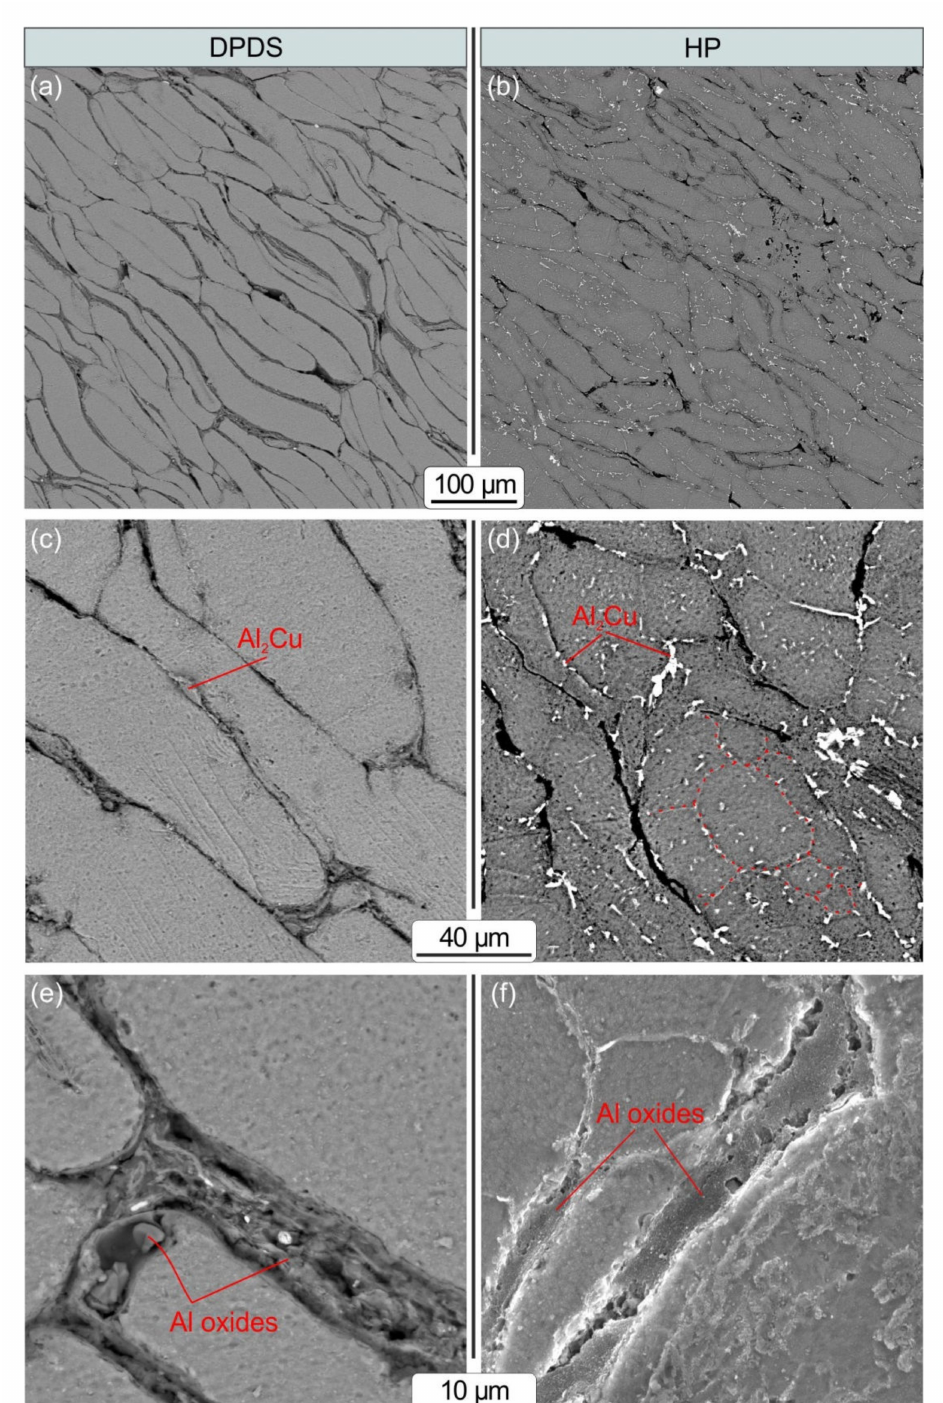
Figure 5. Microstructure of the nanocomposite AA2024-2 wt.% MWCNTs produced via DPDS ( a , c , e ) and HP, ( b , d , f